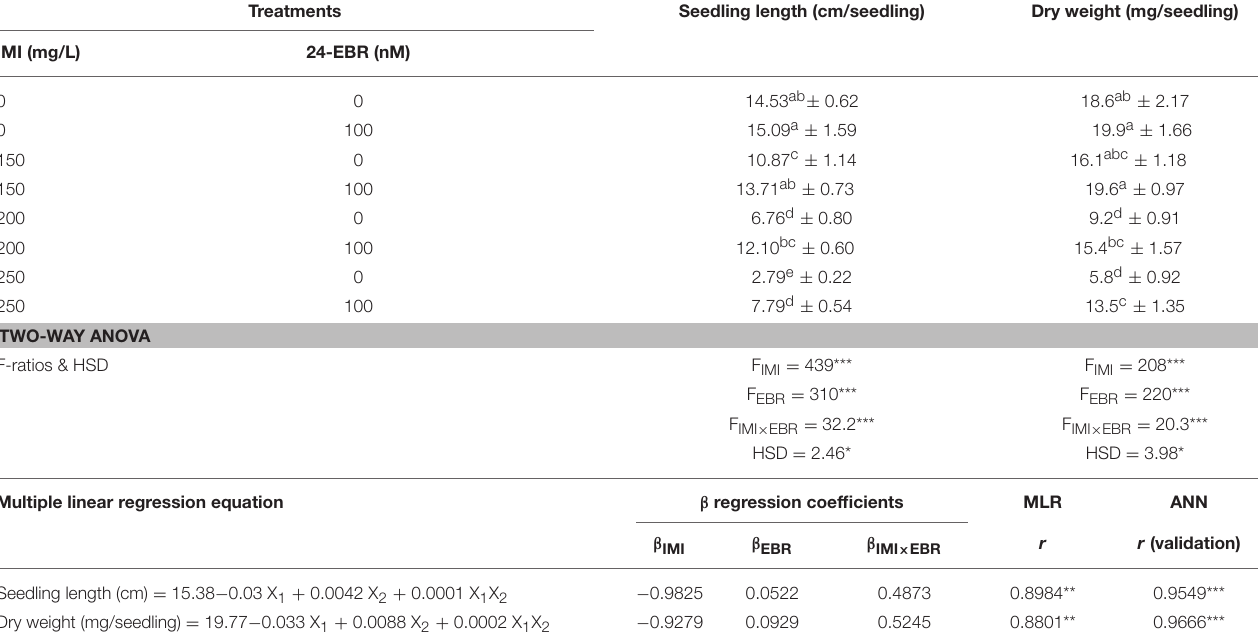
TABLE 2 | Effect of seed soaking with 24-epibrassinolide (EBR) on growth parameters in Brassica juncea seedlings grown under imidacloprid (IMI) toxicity.